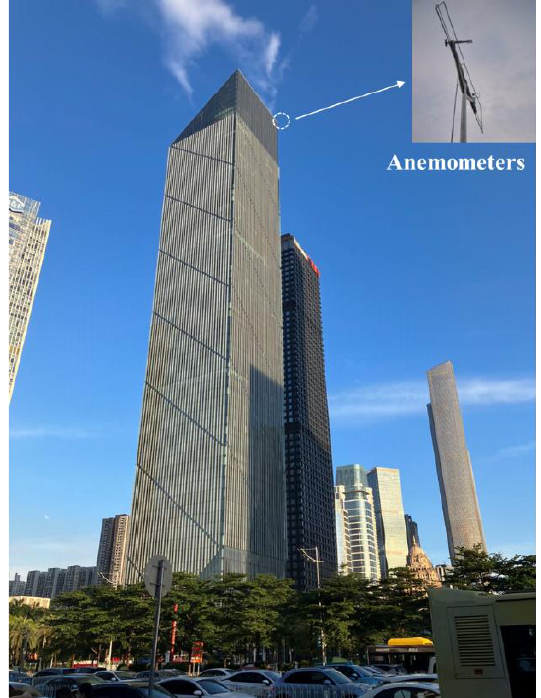
Figure 1. Overview of Leatop Plaza.